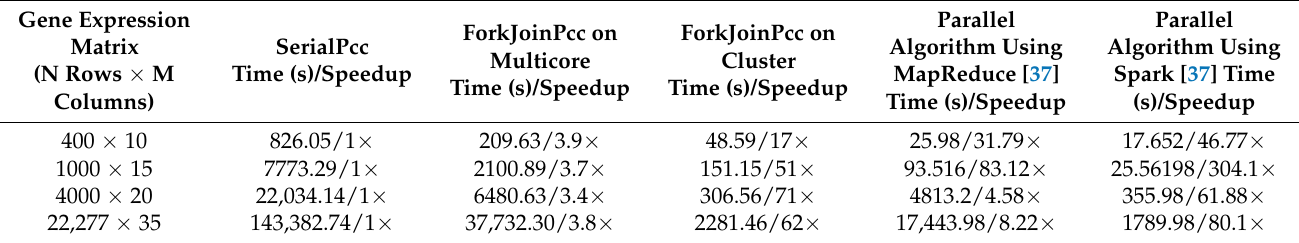
Table 4. Speedup of the ForkJoinPcc algorithm on different